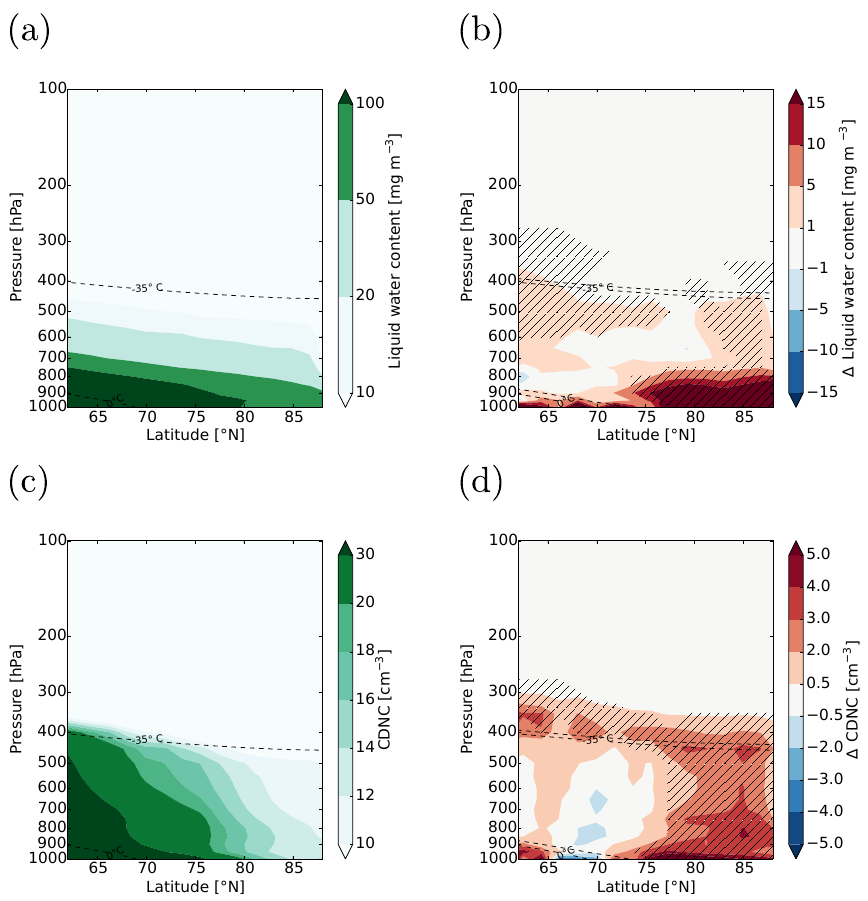
Figure 4. LWC and CDNC in 2004 in (a) and (c) and differences between 2050 and 2004 (i.e. between simulations arctic_2050_EM2004 and arctic_2004) in (b) and (d) (in-cloud values) in early autumn (September–October). Hatched areas are significant at the 95% confidence level. The dashed lines show the 0 and the − 35 ◦ C